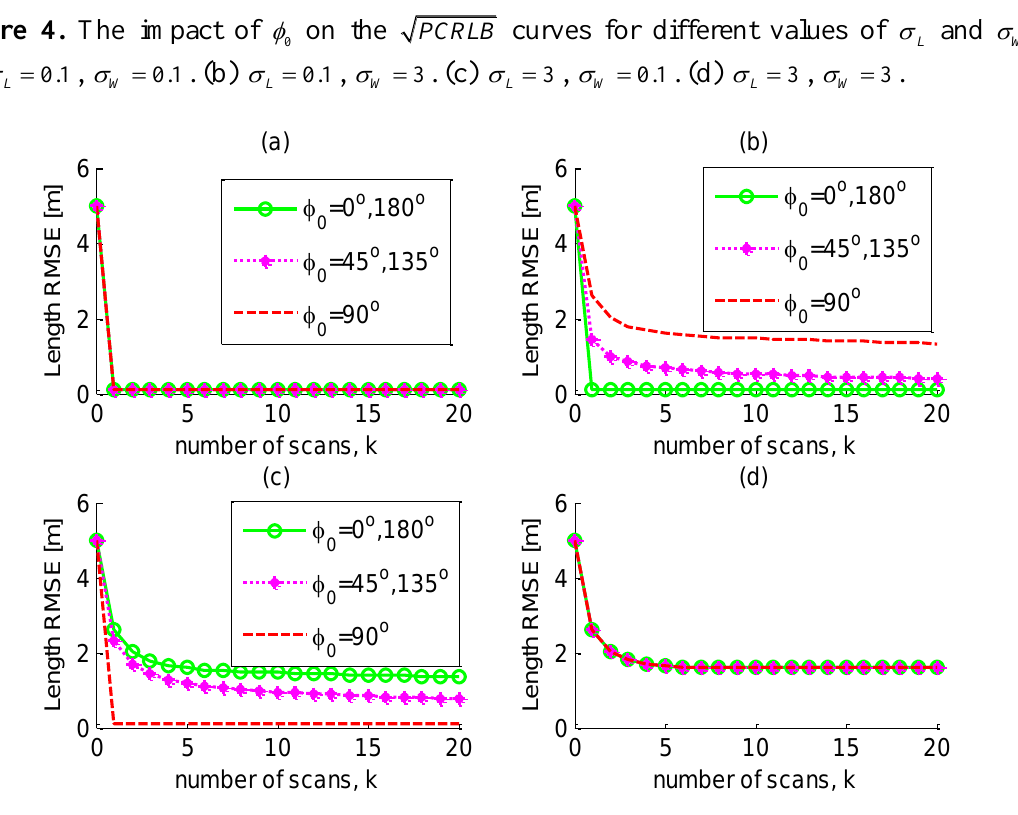
Figure 4. The impact of